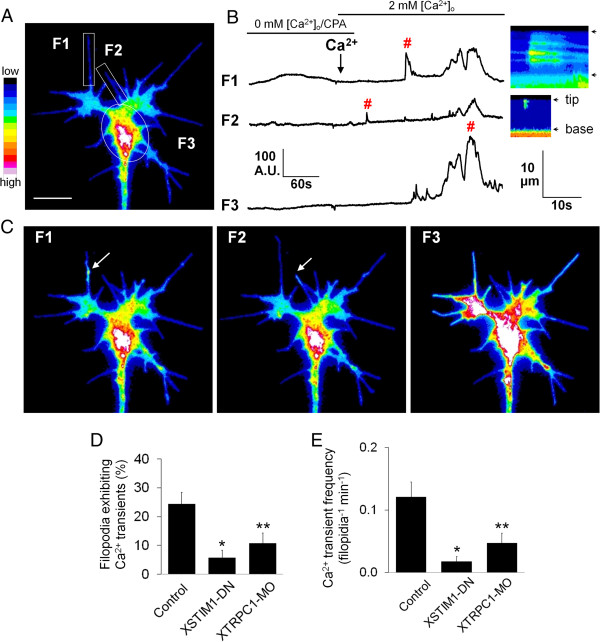
STIM1-dependent SOCE generates filopodial Ca2+ entries in Xenopus neuronal growth cones. (A) A pseudocolored Lck-GCaMP3 fluorescent Ca2+ image of growth cone showing rectangular ROIs (region of interest) used to measure fluorescent intensities over time. Pseudocolors indicate Ca2+ levels, with white as the highest and black as the lowest. Scale bar, 10 μm. (B) Representative traces of Lck-GCaMP3 fluorescent Ca2+ signals profile measured in two filopodia (F1, F2) and a growth center (F3) over 7 min period of store-depletion and re-addition of extracellular Ca2+. Images were captured at 200 milliseconds intervals. #, indicates filopodial and global Ca2+ transients that are shown in (C). Right images are kymographs generated from a segmented line along the filopodia from the tip to the base using NIH ImageJ. The arrowheads denote tip and base of filopodia. (C) Representative pseudocolored Lck-GCaMP3 fluorescent Ca2+ images at the time point as indicated by # in B. The arrows show the initiation of filopodial Ca2+ transients. (D-E) The incidence (D) and frequency (E) of filopodial Ca2+ transients were determined in control (n = 21), XSTIM1-DN (n = 12), XTRPC1-MO (n = 10) expressing filopodia. *P < 0.005 and **p < 0.05 compared with control condition using t-test. Values represent mean ± s.e.m.